Question: Provide a one-line summary of what is displayed.
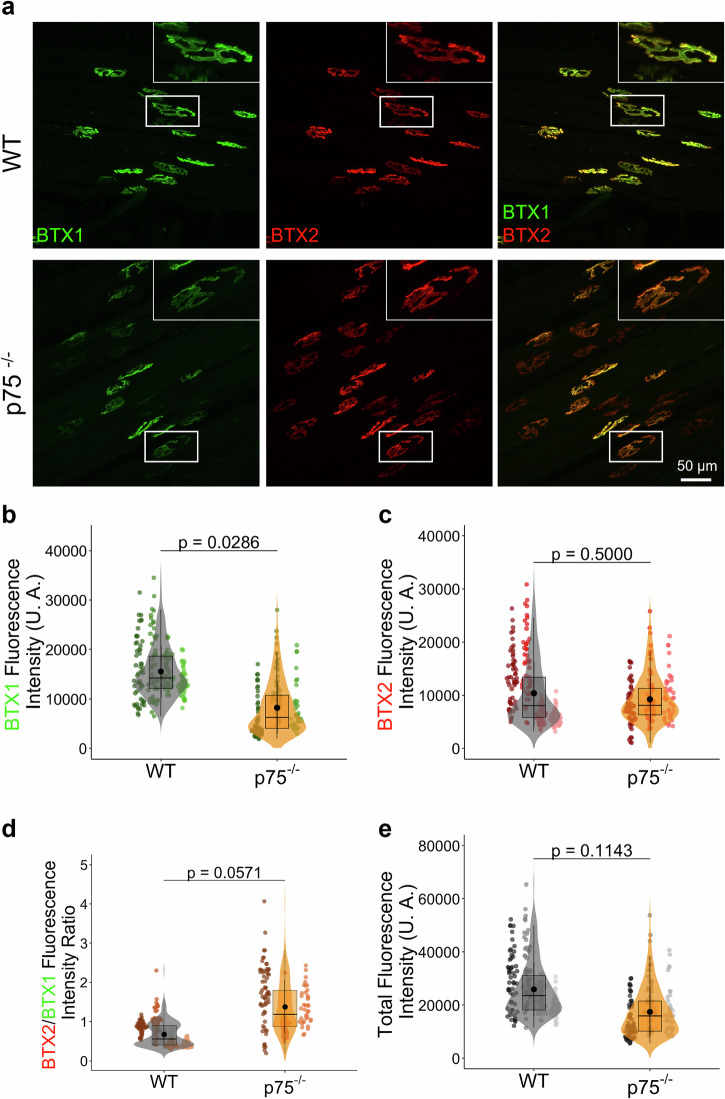
Answer: p75 inhibition destabilises the aged postsynaptic domain at the NMJ. Aged control and p75⁻/⁻ mice were injected subcutaneously in the head/neck region with Alexa-488-conjugated BTX (green; BTX1). After 7 days, LAL muscles were dissected and stained with Alexa-555 BTX (red; BTX2). Changes in BTX1 fluorescence intensity reflect alterations in pre-existing, membrane-bound AChRs, whereas BTX2 labeling reflects the insertion of newly synthesised receptors. a Representative confocal images of NMJ postsynaptic domains. Scale bar = 50 µm. Quantification of BTX1 ( b ) BTX2 ( c ) fluorescence intensity, BTX2/BTX1 ratio ( d ) and total staining intensity (BTX1 + BTX2) ( e ). Data are shown as violin plots with individual NMJs overlaid (dots) and per-animal values (columns; N = 3–4 mice, 38–63 NMJs per mouse). Statistical analyses were performed using animal means; individual NMJs are shown to illustrate within-animal variability. p values were estimated using Mann–Whitney test ( b – e ).